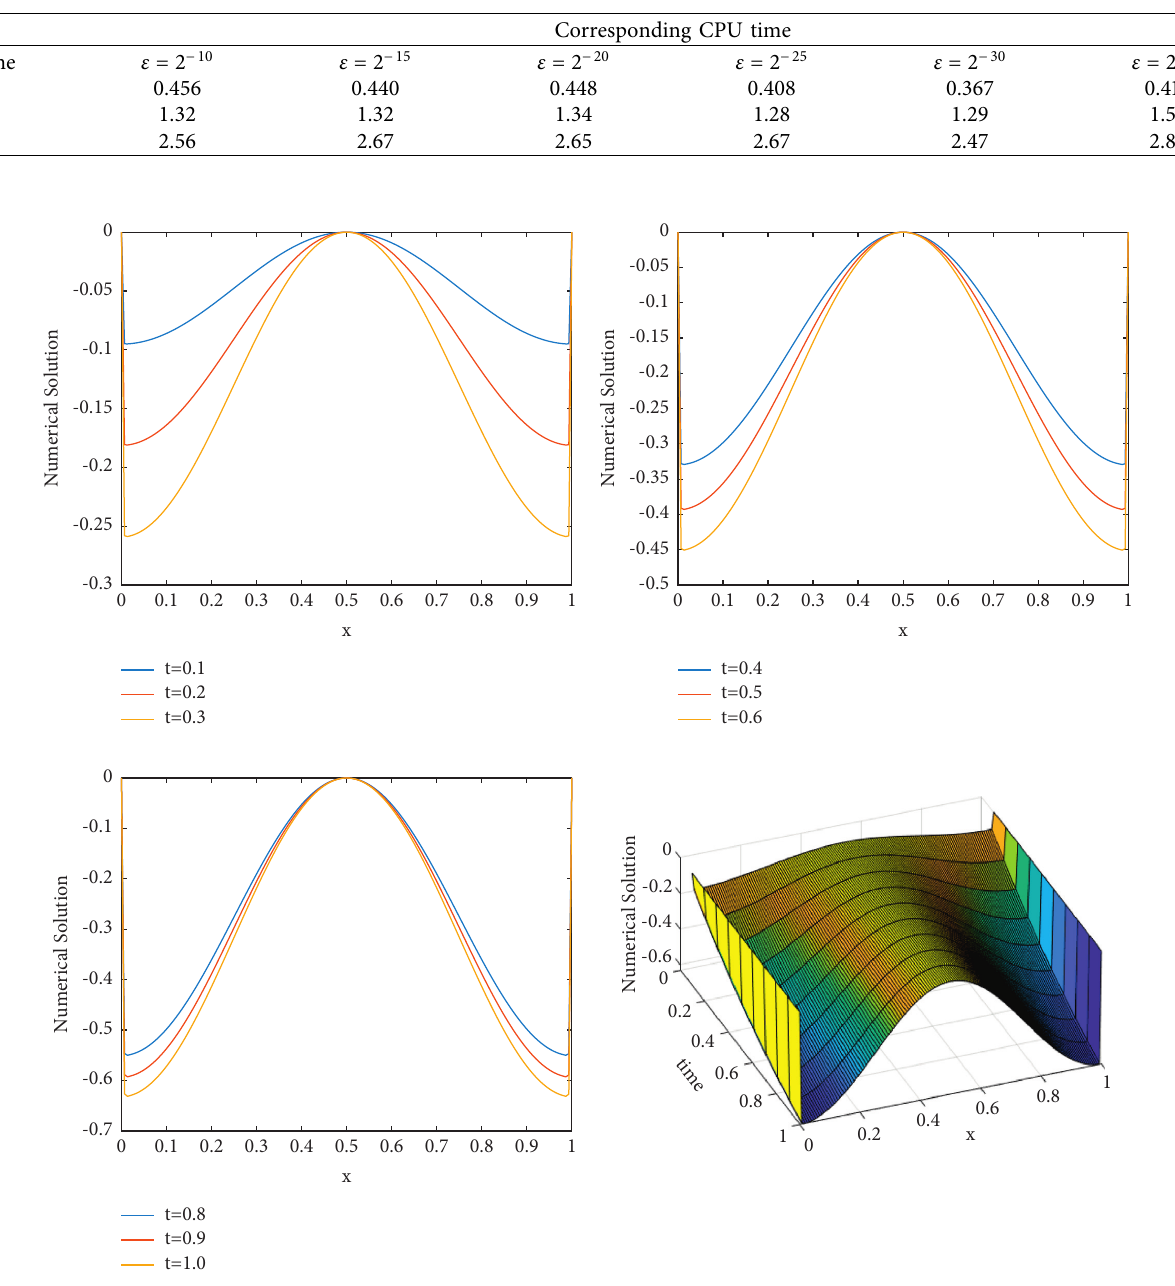
Table 3: Maximum absolute L